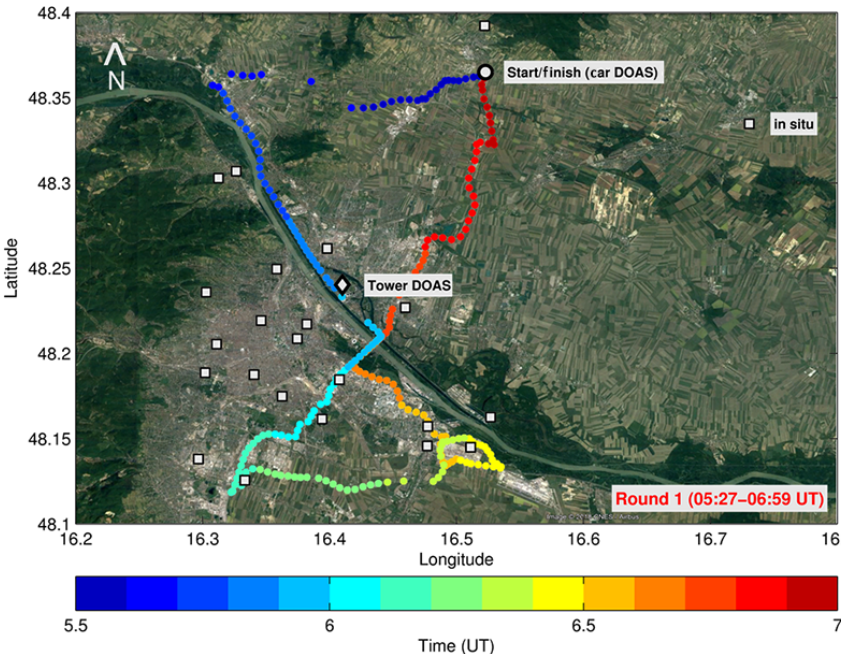
Figure 1. Overview map with an example of a single car journey (color-coded dots) as performed on 10 April 2015 between 05:27 and 06:59UT. The locations of the start and finish of the car journeys, Danube Tower, and in situ measurement stations are shown by a circle, diamond, and squares, respectively.